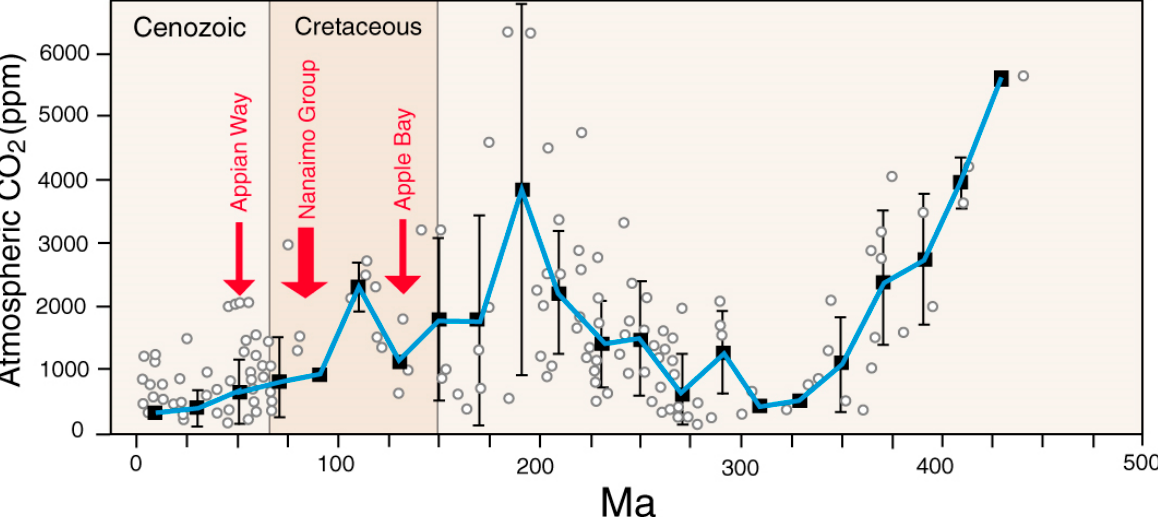
Figure 9. Atmospheric CO 2 levels through deep time. Adapted from [41].